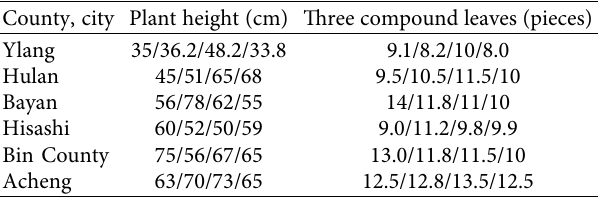
Table 3: Soybean growth monitoring questionnaire (18/19/20/21 years)